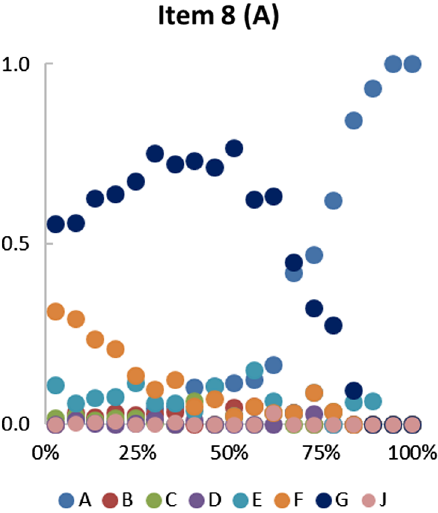
FIG. 1. IRCs of item 8 of the FMCE American data. A, American